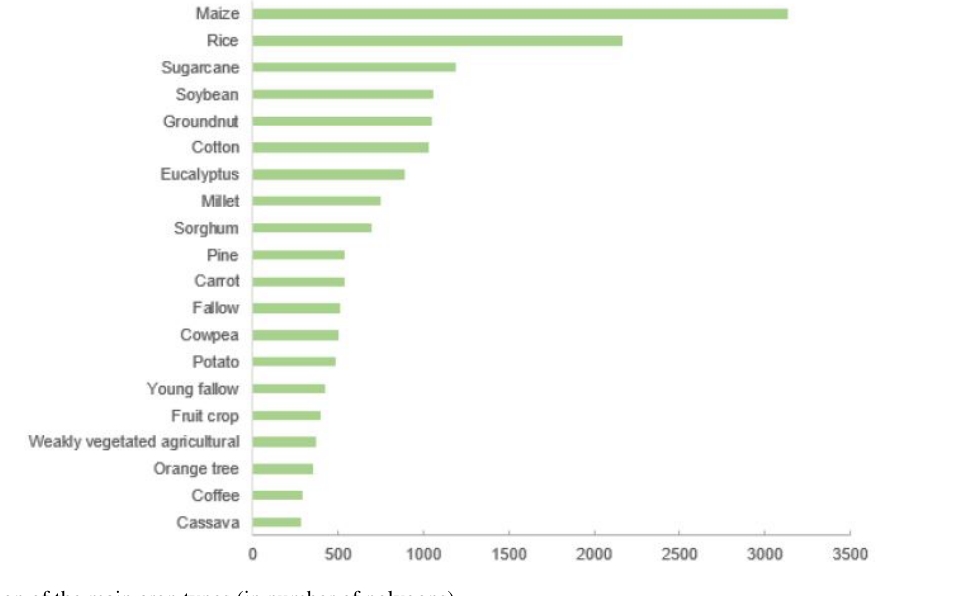
Figure 5. Distribution of the main crop types (in number of polygons).